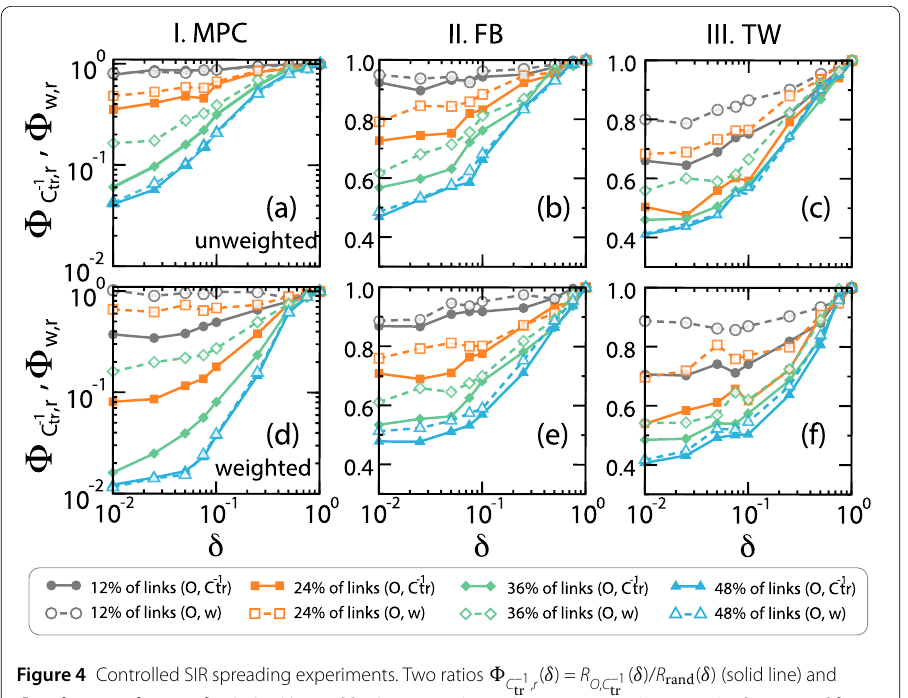
Figure 4 Controlled SIR spreading experiments. Two ratios (cid:7) (cid:7) w , r ( δ ) = R O , w ( δ )/ R rand ( δ ) (dashed line) of final recovered population sizes are shown as the function of δ rescaling parameter in case of ( O , C –1 tr ), ( O , w ) and random control strategies when we control the 12% (gray), 24% (orange), 36% (green), 48% (blue) of links. We present results for unweighted ( a ) MPC, ( b ) FB, ( c ) TW and weighted ( d ) MPC, ( e ) FB, ( f ) TW networks. Results were obtained averaging over SIR spreading processes with parameters β = 0.25 and μ = 0.1 initiated from 1000 random